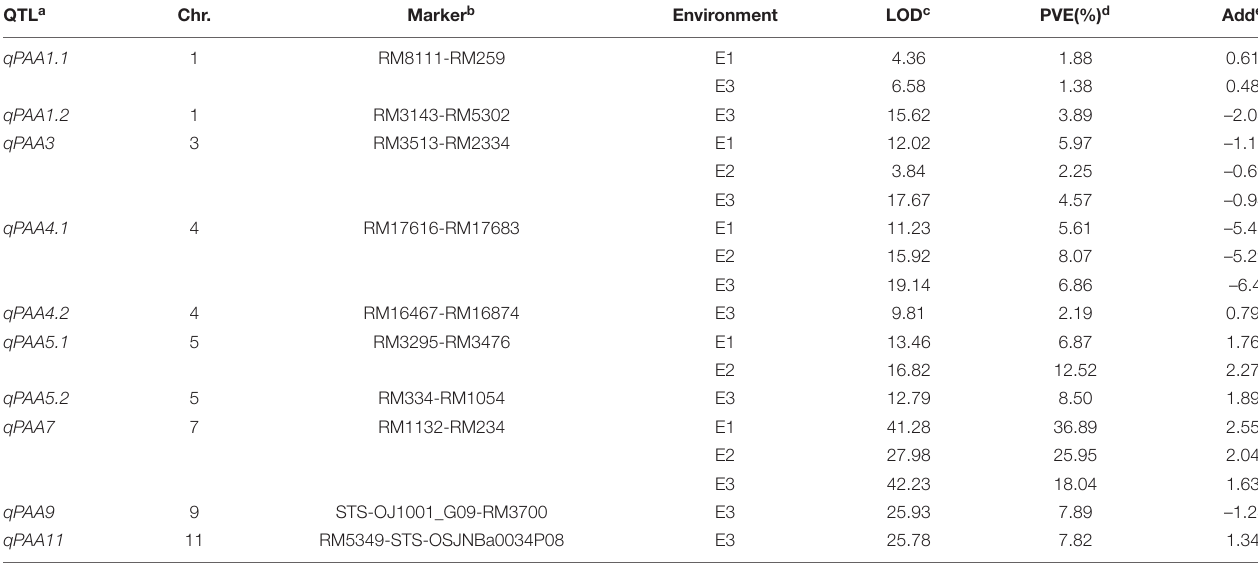
TABLE 3 | Detected QTLs affecting PAA traits using CSSL population across three environments. QTL a Chr.